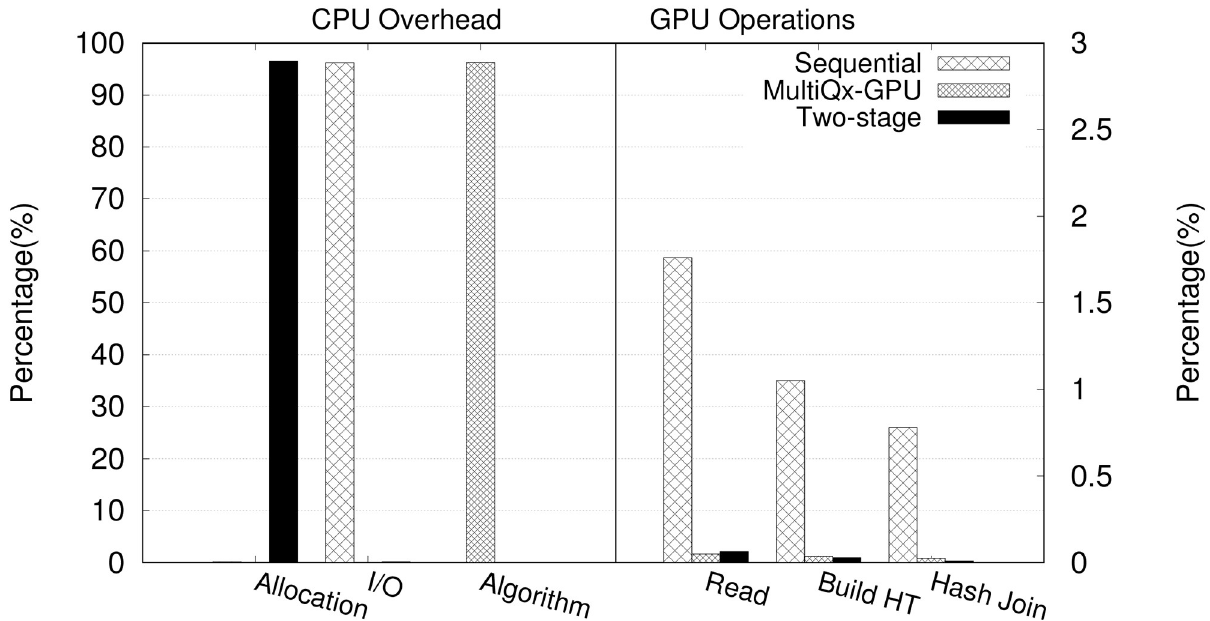
Fig 8. Percentage of execution time of two table hash join with sequential execution, MultiQx-GPU Optimization and Two-stage Model. table, building hash table, and hash join against sequential execution of MultiQx-GPU and Two-stage Model are 0.999x and 0.997x, 0.90x and 1.12x, and 0.92x and 2.53x, respectively.